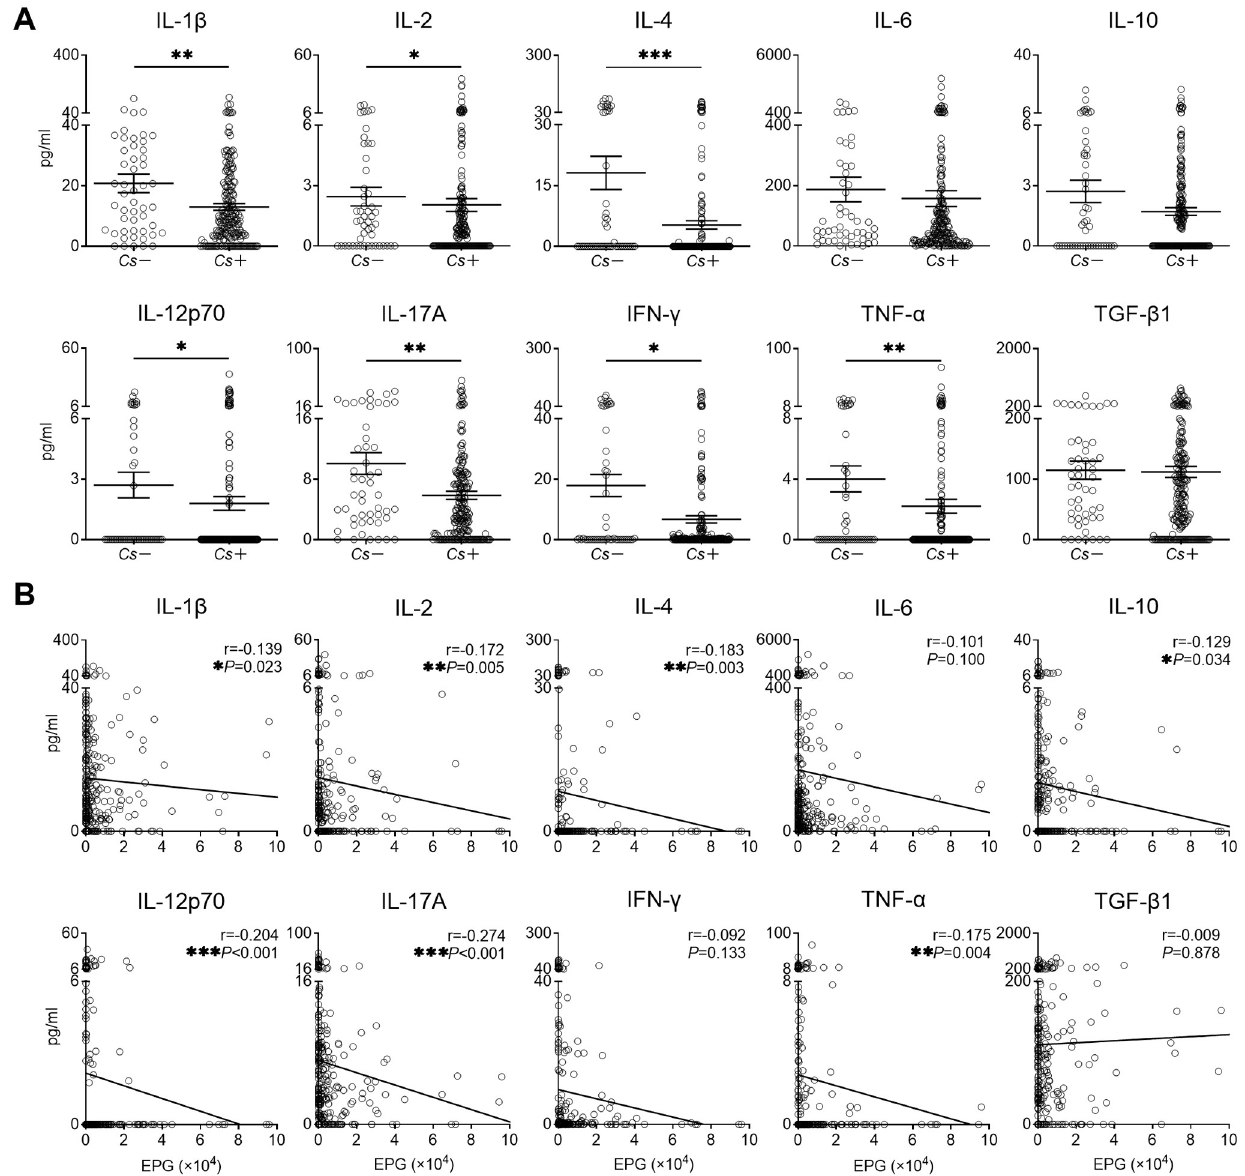
Fig 7. Serum levels of antibodies and cytokines in Cs - and Cs + individuals excluding co-infection with soil-transmitted helminths. (A) Serum levels of IL-1 β , IL-2, IL-4, IL-6, IL-10, IL-12p70, IL-17A, IFN- γ , TNF- α and TGF- β 1 in Cs - individuals (n = 50) and Cs + individuals (n = 218) excluding co-infection with soil-transmitted helminths. (B) Spearman’s correlation analysis between EPG and serum levels of IL-1 β , IL-2, IL-4, IL-6, IL-10, IL-12p70, IL-17A, IFN- γ , TNF- α and TGF- β 1 (n = 268). Cs : C . sinensis infection, EPG: eggs per gram of feces. The data were shown as the mean ± s.e.m., � P < 0.05, �� P < 0.01, ��� P < 0.001, Mann-Whitney U test in (A) , Spearman’s correlation test in (B)